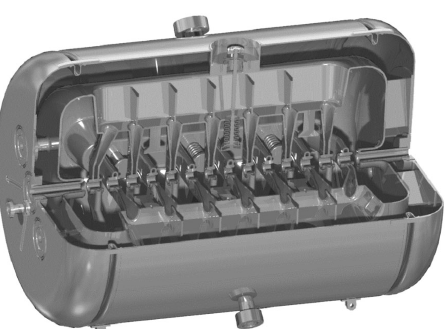
FIG. 2. CH-cavity test environment at GSI.